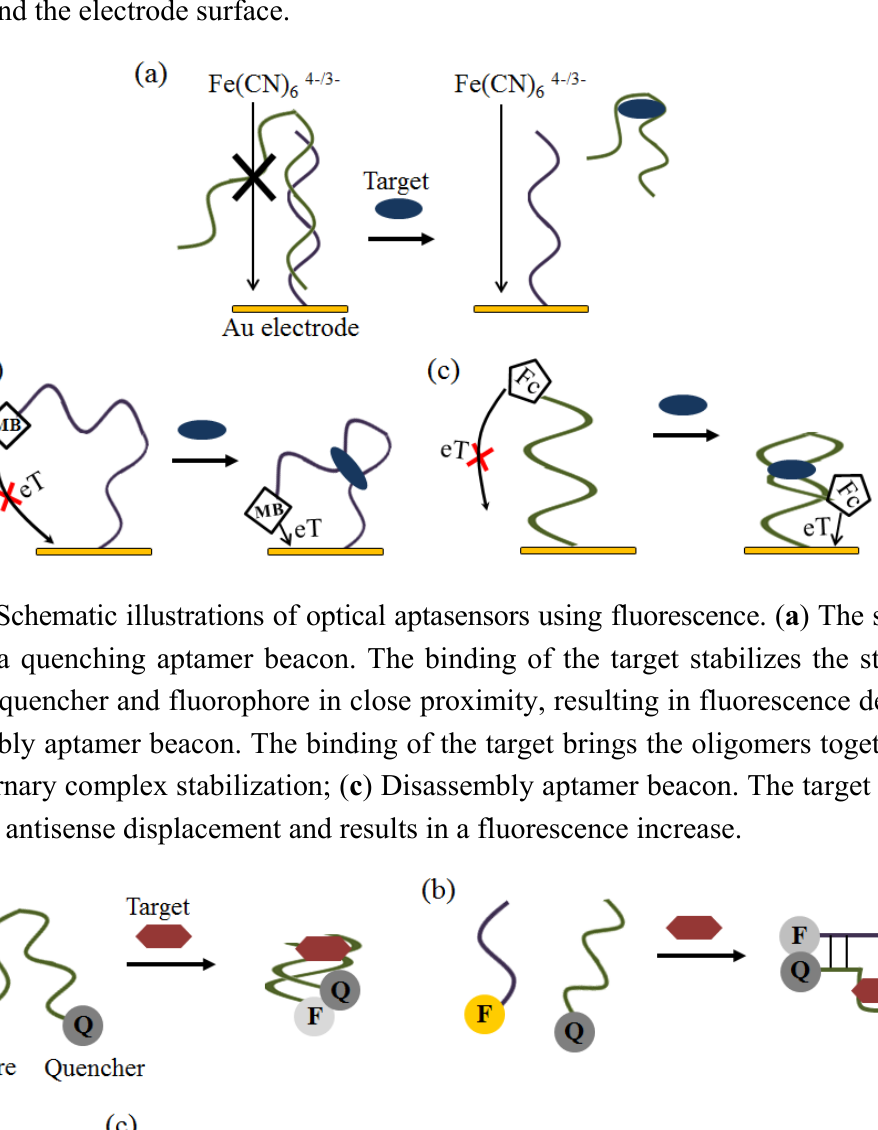
Figure 5. Examples of electrochemical aptasensors. ( a ) A schematic representation of the electrochemical aptasensor using Fe(CN) 64 − /3 − . Part of the aptamer was a hybridized aptamer with complementary DNA, which was immobilized on the gold surface. In the presence of the target, the aptamer was followed by binding with the target, to decrease the amount of the aptamer on the electrode surface; ( b ) A schematic representation of the electrochemical aptasensor using MB. In the presence of the target, the aptamer folds into the target-binding three-way junction, altering the electron transfer (eT) and increasing the observed reduction peak; ( c ) A schematic representation of the electrochemical aptasensor using Fc. In the presence of the target, the aptamer folds into the restricted hairpin structure, and this conformational change results in increased efficiency of eT between the Fc probe and the electrode surface.